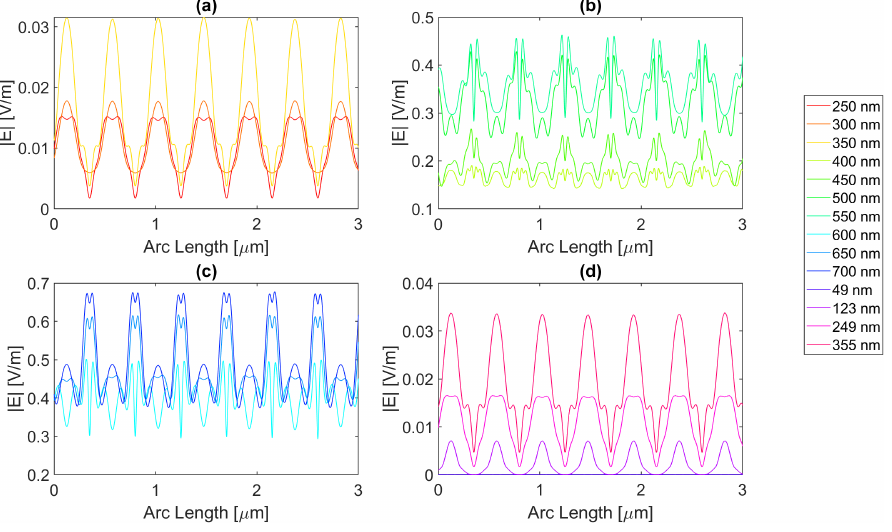
Figure 12. Electric field for the silver circular nanostructure with a 100 nm radius—Probe